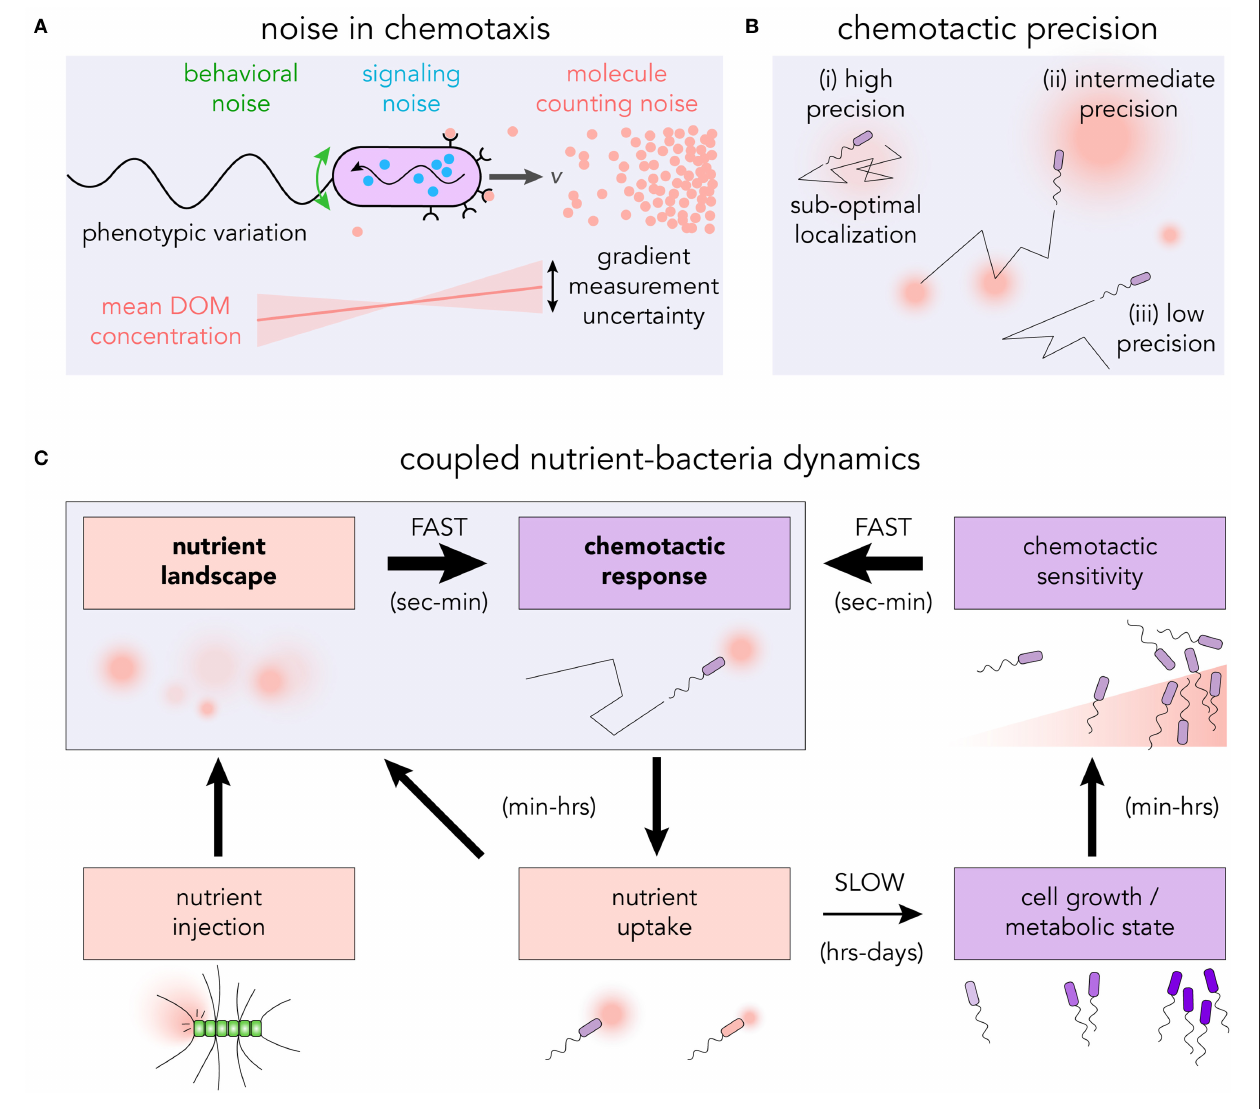
FIGURE 2 | (A) The discrete nature of dissolved chemoattractants introduces molecule counting noise into the bacterium’s measurement of the gradient. In conjunction with other sources of noise in the signaling pathway, the flagellar response as well as rotational diffusion, the cell executes an effective chemotactic response. (B) The level of chemotactic precision governs the ability of bacteria to navigate toward, and reside at, regions of high DOM concentration. (i) High chemotactic precision may result in sub-optimal localization at local nutrient maxima; (ii) intermediate precision allows for both exploration and exploitation; and (iii) low precision results in undirected motility. (C) Highly coupled nutrient-bacteria dynamics in chemotactic foraging cycle. The traditional means of studying chemotaxis is to assess the motility response to prescribed nutrient landscapes (seconds to minutes). However, over timescales of hours to days, feedback loops exist which have the capacity to reshape the nutrient landscape and modify the chemotactic